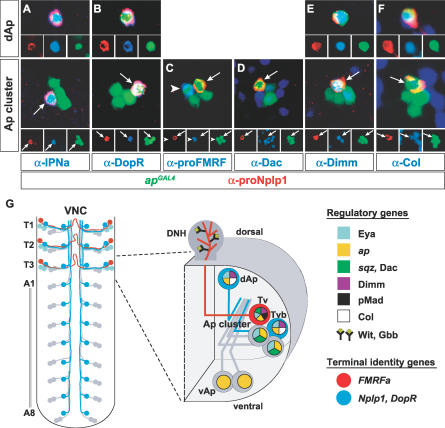
A Specific Subset of Ap Neurons, the Tvb and dAp Cells, Expresses the Nplp1 Neuropeptide, the DopR Dopamine Receptor and the Col Transcription FactorStaining for apGAL4 (green) and proNplp1 (red), and IPNamide (A), DopR (B), proFMRF (C), Dac (D), Dimm (E), and Col (F) (blue). Arrows denote the Tvb neuron, and arrowheads the Tv neuron.(A and B) Co-expression of proNplp1 with IPNamide (A) and DopR (B) in dAp neurons (top) and one Ap cluster neuron (bottom).(C and D) No co-expression between proNplp1 and proFMRFa (C) or Dac (D).(E and F) Co-expression between proNplp1 and Dimm (E) or Col (F). The Tvb neuron is identified by its expression of ap, Eya, Dimm, DopR, and Nplp1, but not Dac or FMRFa.(G) Cartoon summarizes the expression of regulatory genes and terminal identity genes in Ap neurons. DNH, dorsal neurohemal organ; vAp, ventral Ap neurons.All images are from 18-h AEL VNCs.